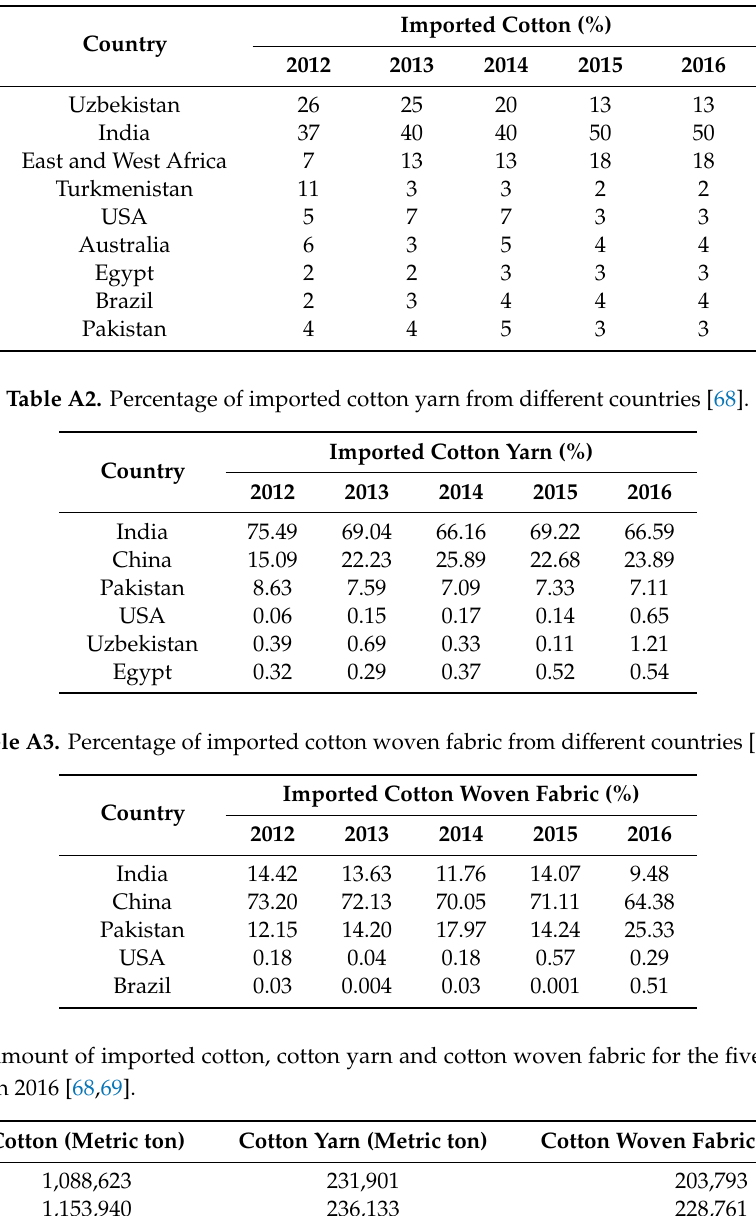
Table A1. Percentage of imported cotton from di ff erent countries [65–67].